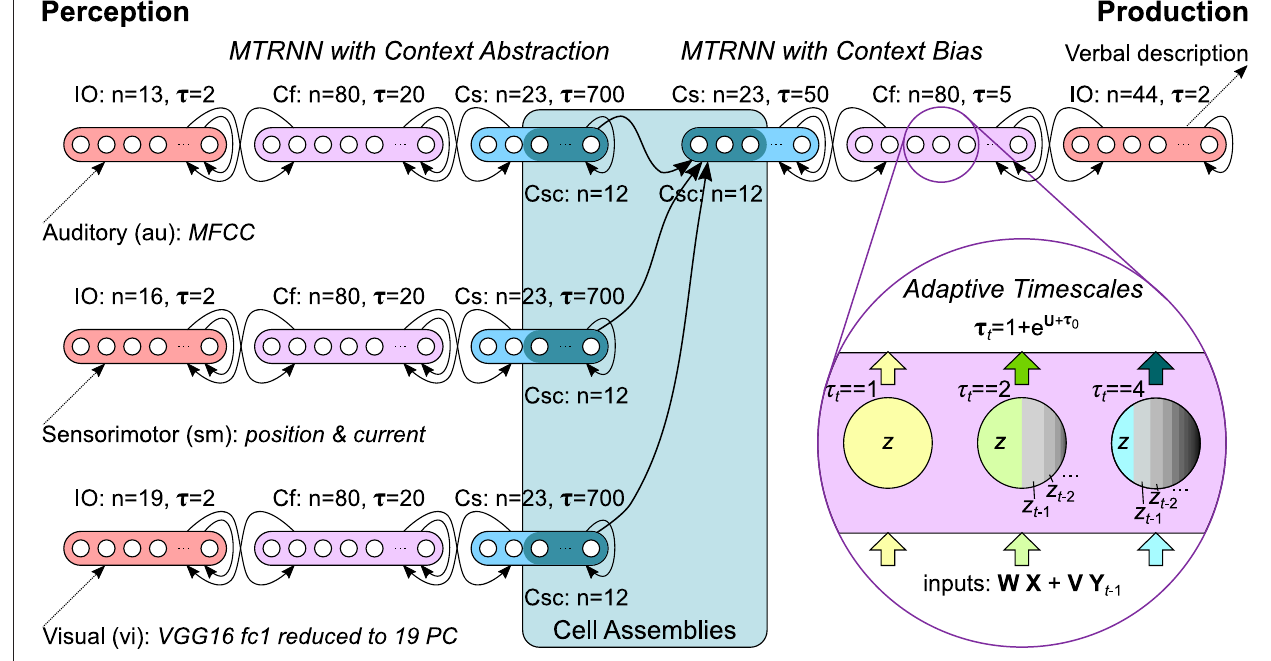
FIGURE 1 | Computational model: Adaptive MTRNNs with context abstraction for each input modality are coupled with an adaptive MTRNN with context bias via cell assemblies. Example timescales visualize the logarithmic leakage of information in the neurons.